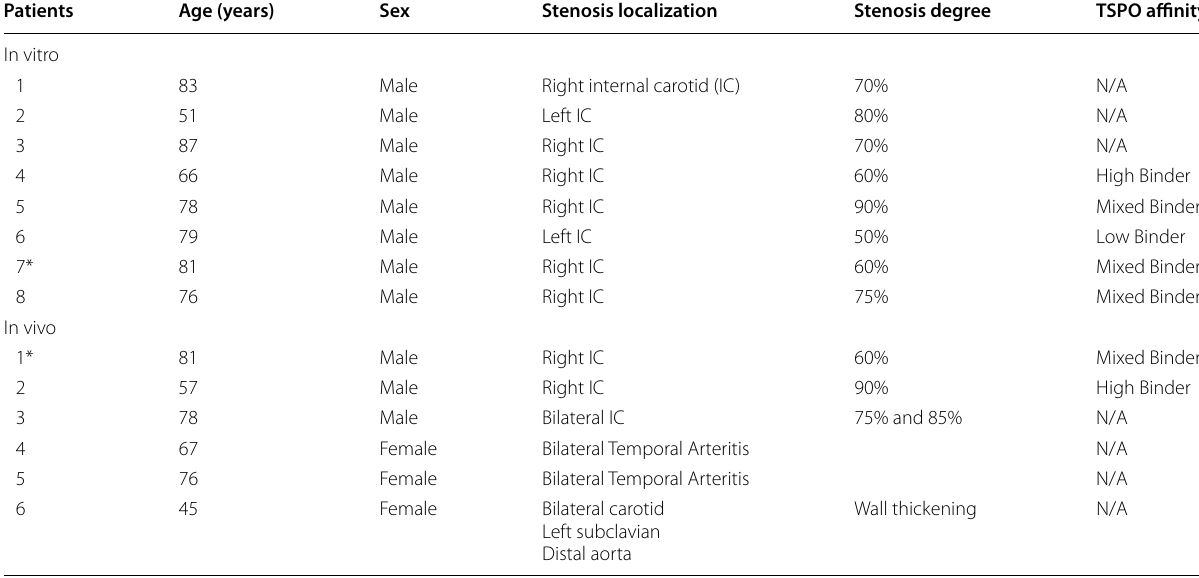
Table 1 Characteristics of patients in the in vitro and in vivo parts of the study